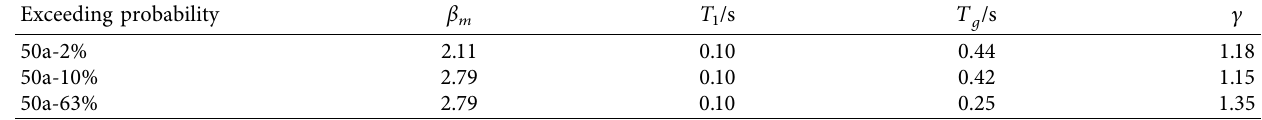
Table 7: Two-parameter calibration method to calibrate the design spectral characteristic parameters.